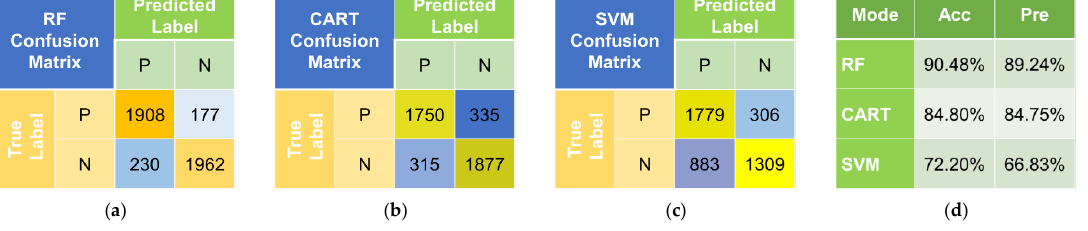
Figure 9. The landslide susceptibility of the central Hengduan Mountains. ( a ) is the LS map of the Hengduan Mountains region; ( b ) shows the landslide assessment result of this area; ( c , d ) are field photos showing the geological disasters that happened at differentsites; ( c-1 ) is a close-up view of c, and ( c-2 ) is a detailed picture of the landslide disaster.